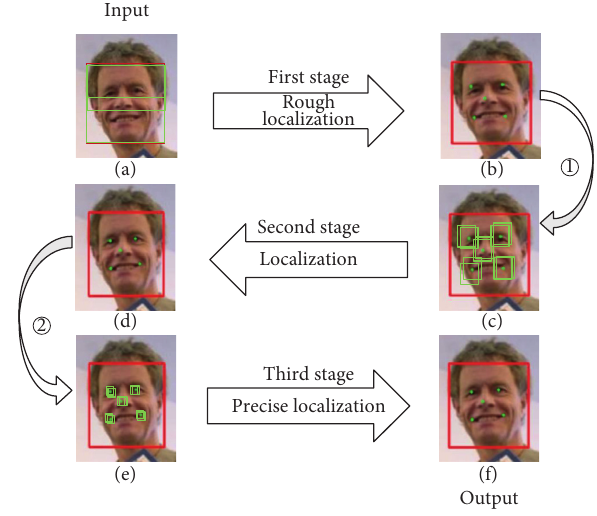
Figure 1: CCNN algorithm